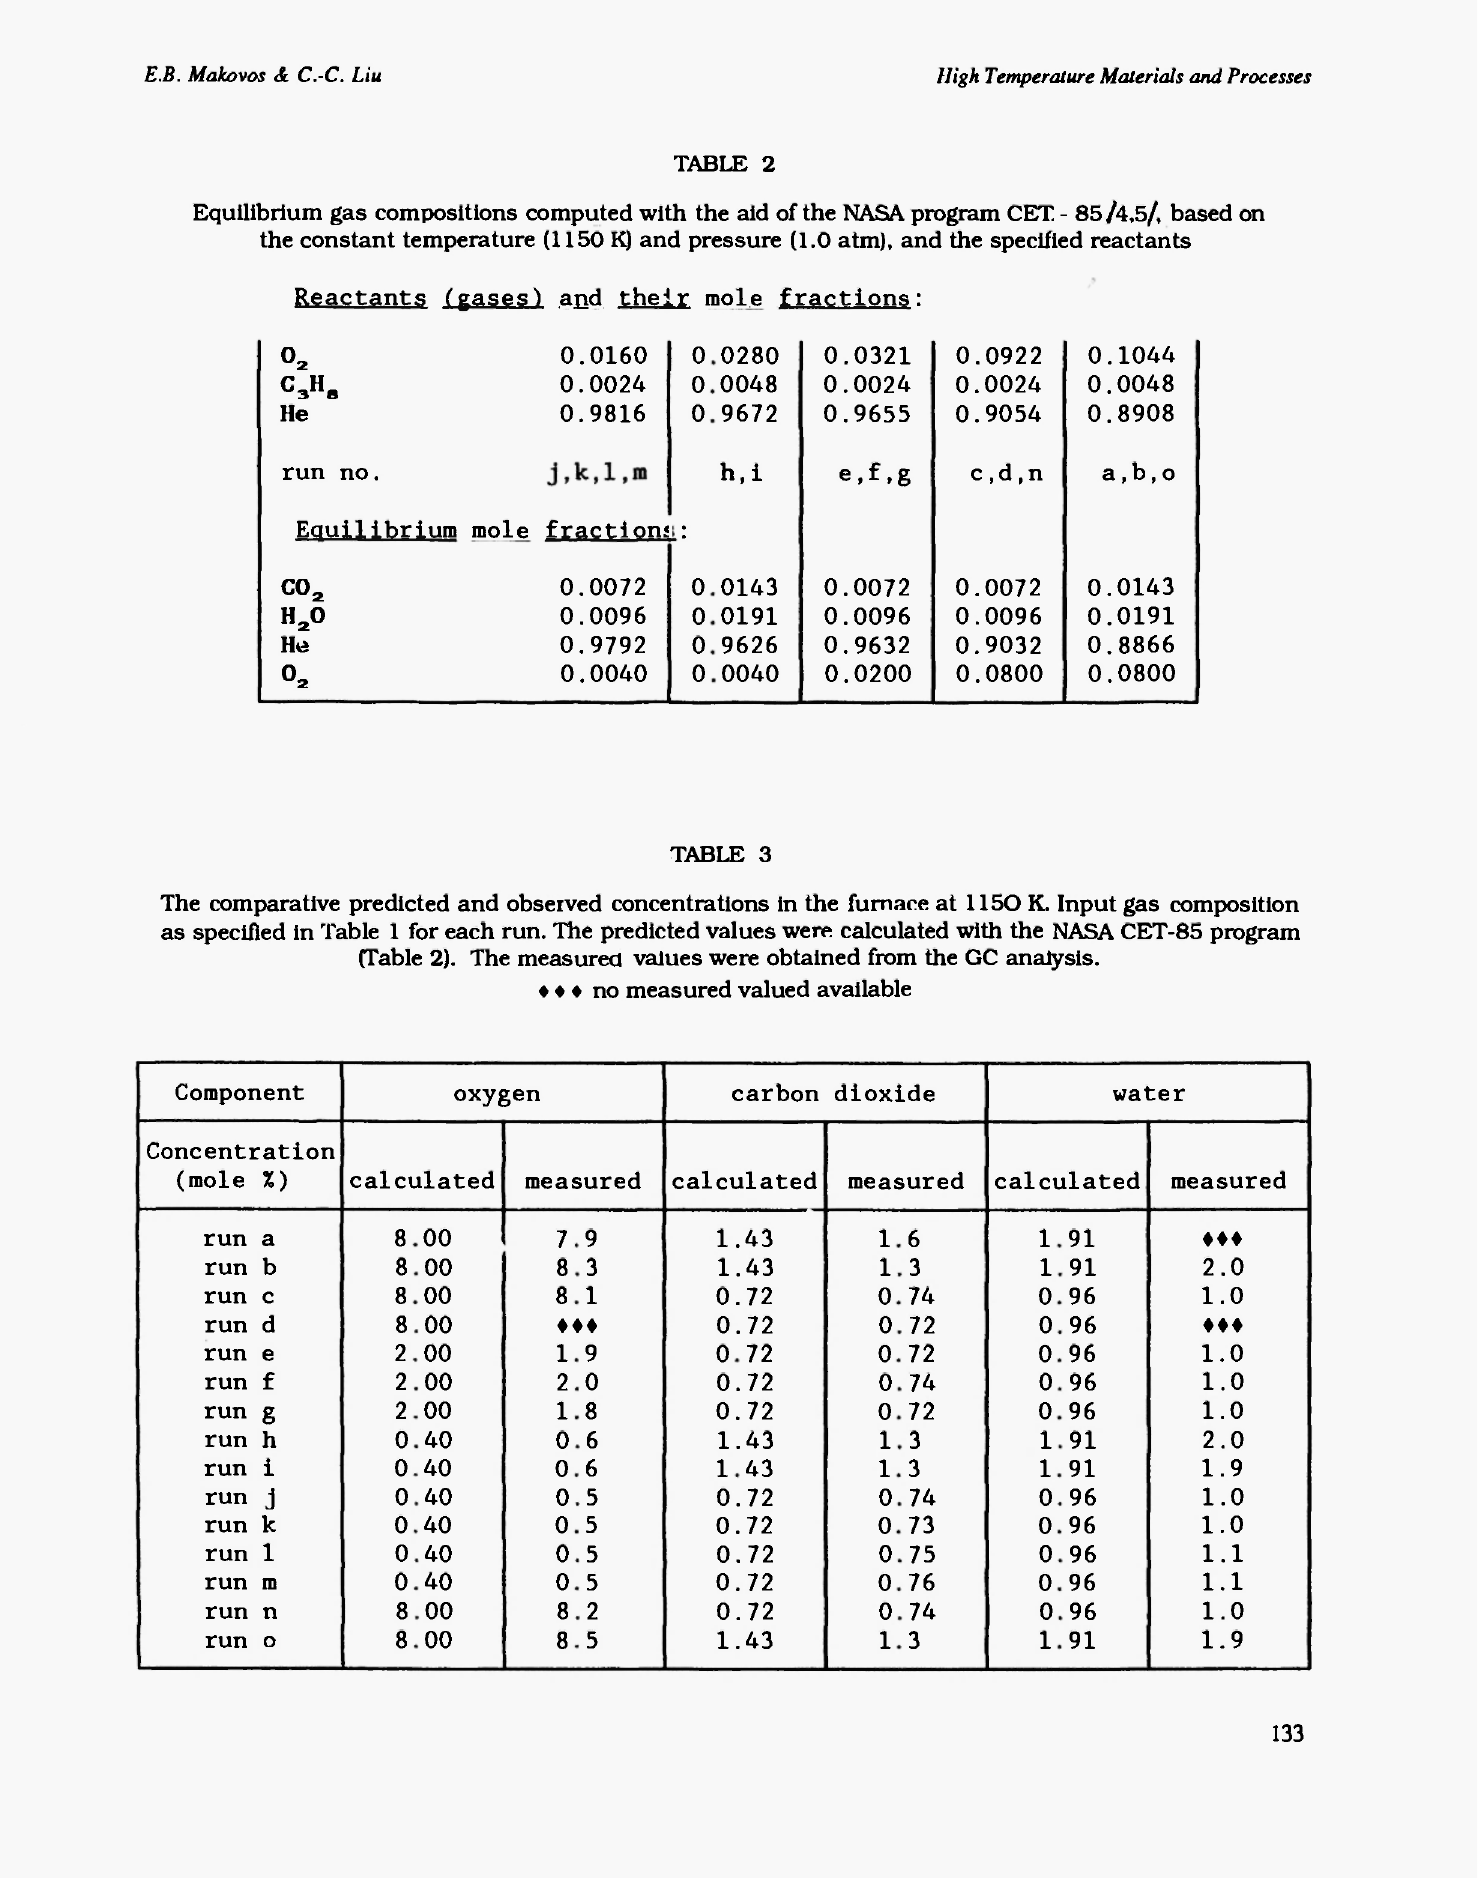
The comparative predicted and observed concentrations in the furnace at 1150 K. Input gas composition as specified in Table 1 for each run. The predicted values were calculated with the NASA CET-85 program (Table 2). The measured values were obtained from the GC analysis. • • • no measured valued